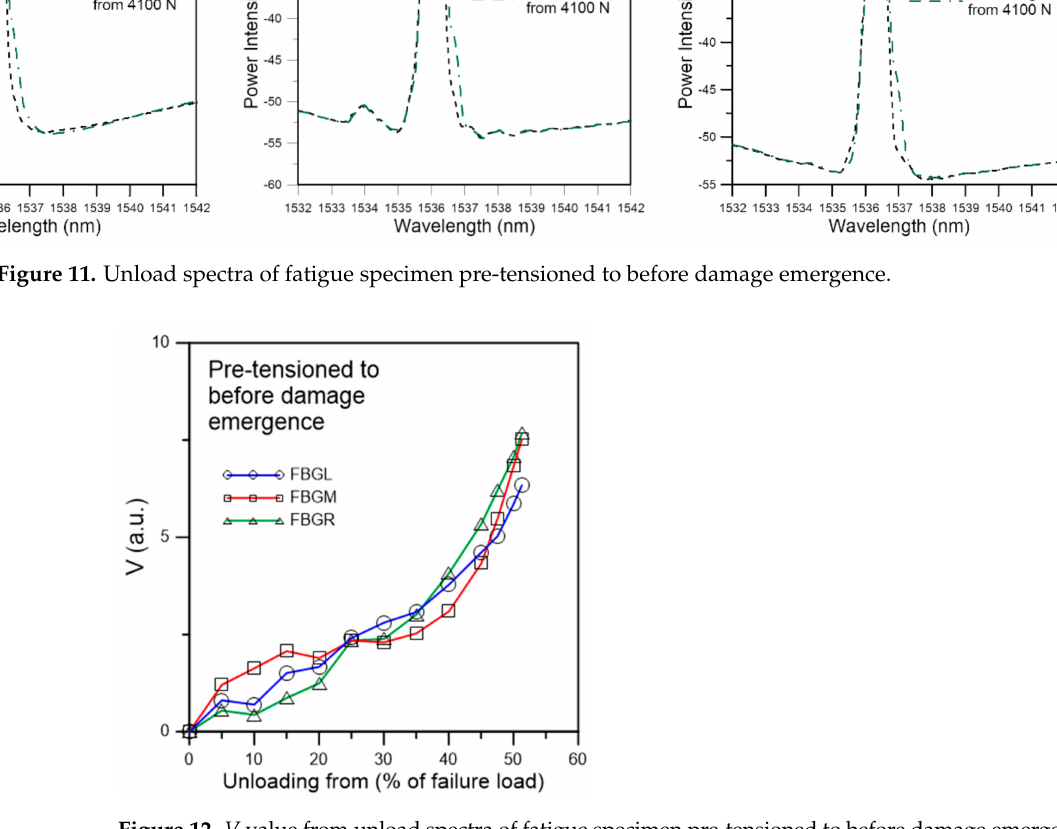
Figure 12. V value from unload spectra of fatigue specimen pre-tensioned to before damage emergence.